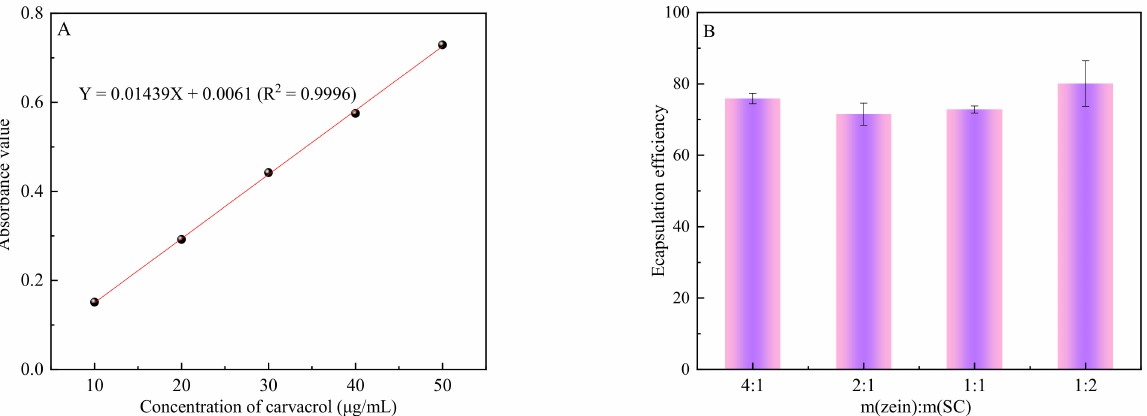
Figure 2. Encapsulation efficiency of nanoparticles with different zein/SC mass ratio. ( A ) The standard curve of CA. ( B ) Encapsulation efficiency of nanoparticles with zein/SC mass ratios of 4:1, 2:1, 1:1, and 1:2.